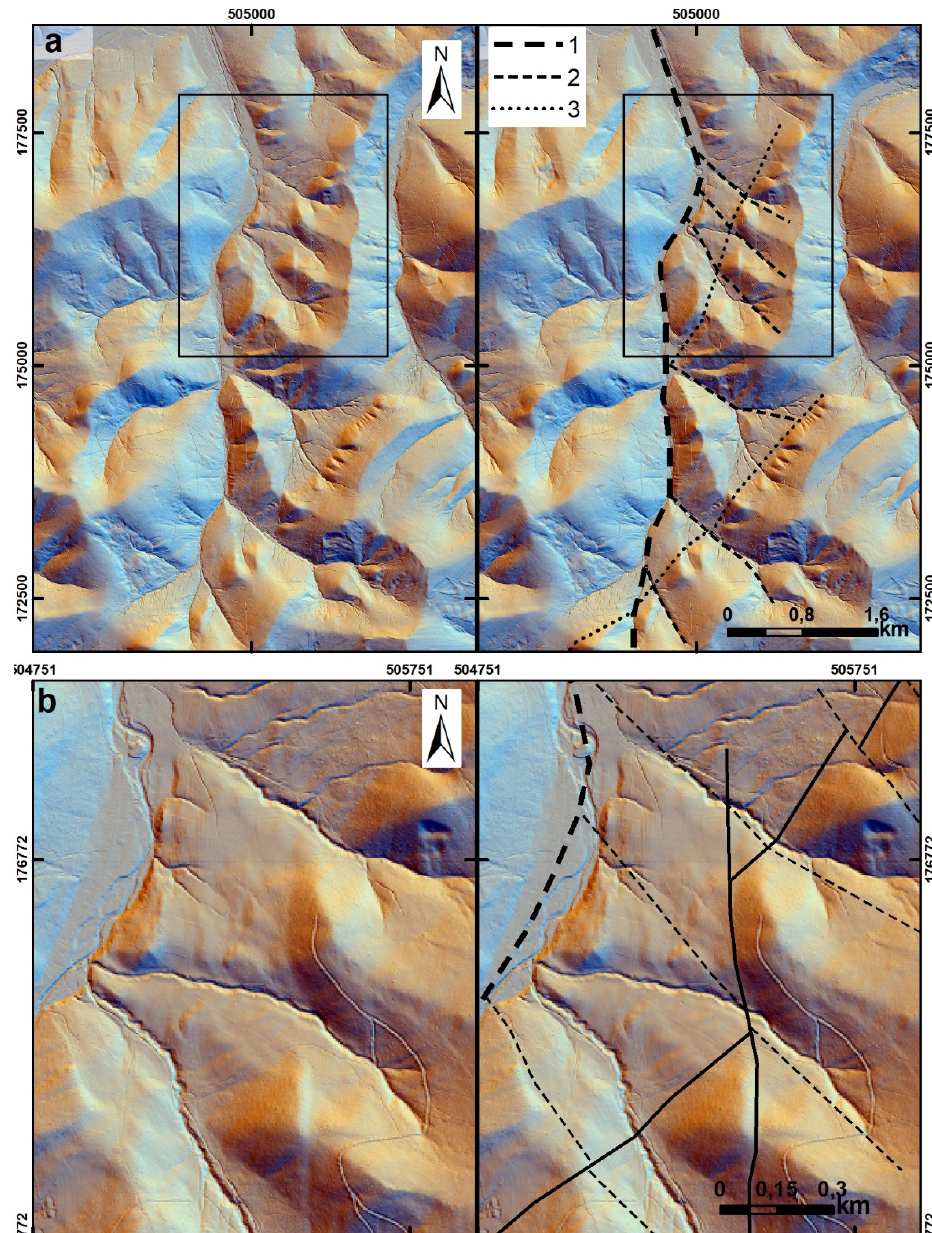
Figure 10. ( a ) Trace of the Rycerka Fault (thick dashed line—1) with subsidiary faults (thin dashed lines—2) visible on the LiDAR-based DEM. Dotted lines (3) mark the trace of younger generation normal faults, ( b ) LiDAR-DEM showing morpho-structural lineaments interpreted as faults system on the eastern flank of the Rycerka Fault (thick dashed line). Triangular facet scarps that represent eroded fault planes are marked with pale yellow arrows, solid lines mark the strike of normal faults. Facet scarps can be noticed along the eastern side of the RF, indicating normal faulting also along this fault.